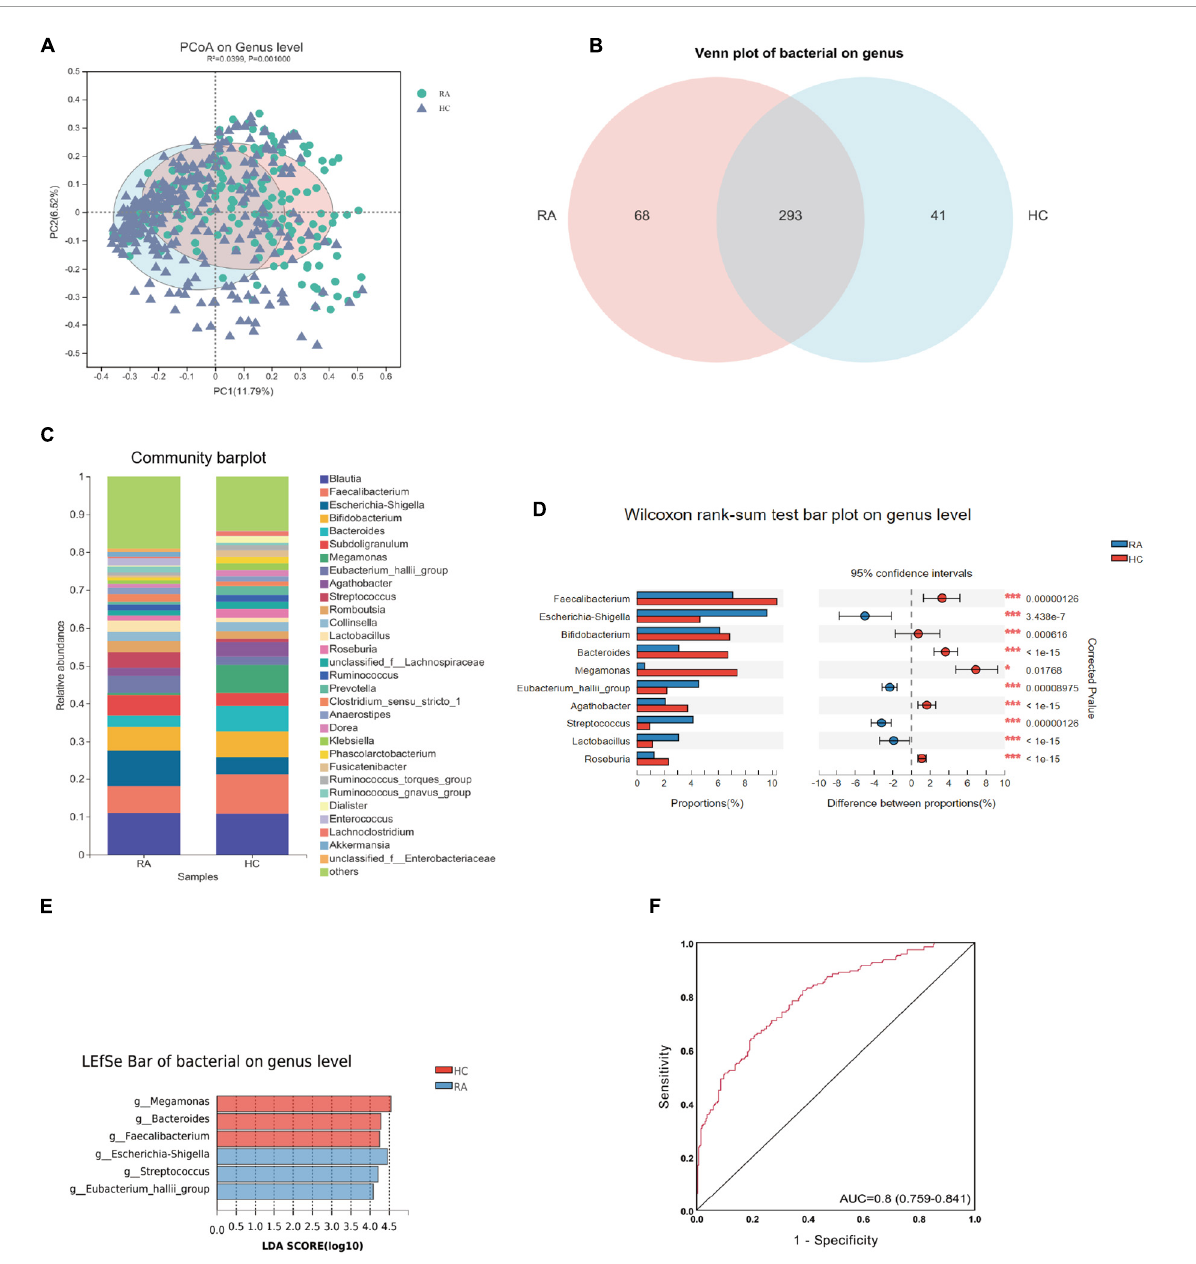
FIGURE4 The differential bacterial flora and predicted enzymes based on 16s rRNA (genus level) between RA and HC groups. (A) The Venn plot between RA and HC groups. (B) The PCoA analysis between RA and HC. (C) The Bar graph of bacterial flora composition in RA and HC. (D) The top 10 significant bacteria between RA and HC. (E) The LDA bar of bacterial flora in RA and HC. (F) The ROC curve of the combination of six differential bacteria for classifying RA patients from HC. RA, rheumatoid arthritis; HC, healthy control; ROC, receiver operating characteristic.